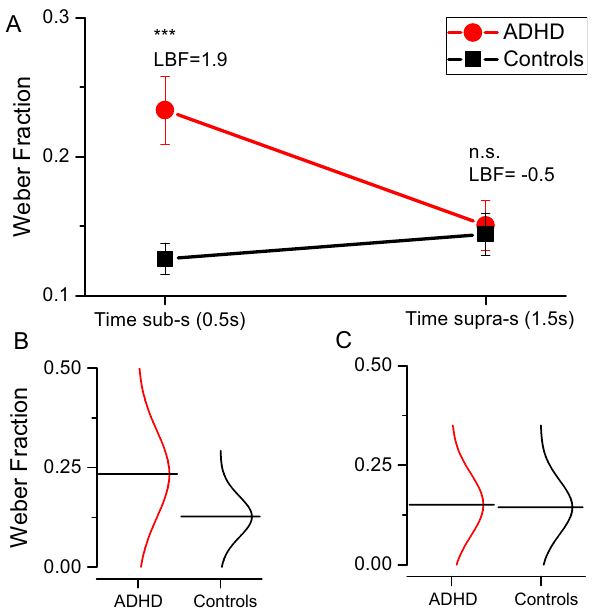
Figure 2. ( A ) Between participants average time thresholds divided by the two groups (ADHD: red circles and Controls: black squares). Error bars are standard errors of the mean; ***p < 0.001; n.s. not statistically different. ( B – D ) Individual data reporting time thresholds distributions. Horizontal lines report data